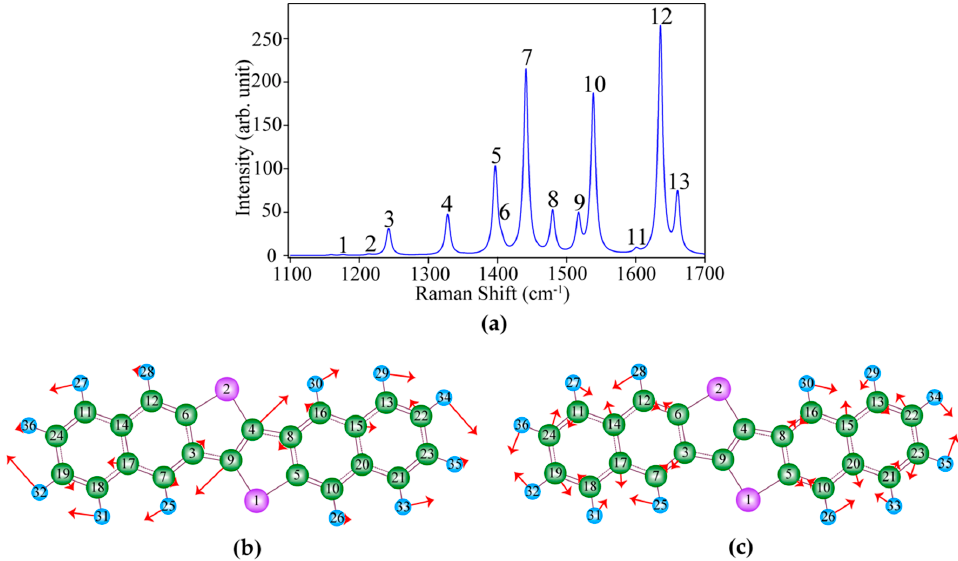
Figure 3. ( a ) A density functional theory (DFT) calculated Raman spectrum of a DNTT molecule; Graphical representations of atomic oscillations for ( b ) peak 10 and ( c ) peak 11.